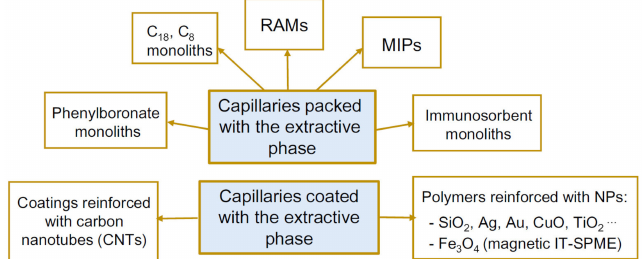
Figure 1. Summary of the extractive phases developed for IT-SPME coupled to capLC and